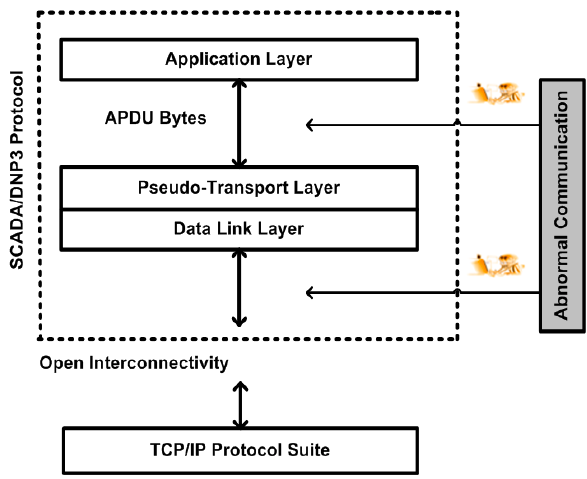
Figure 1. Research scope and study gap.